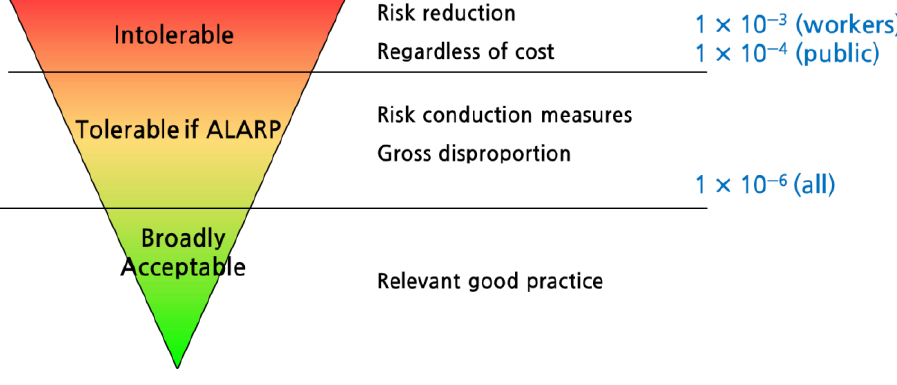
Figure 10. HSE ALARP